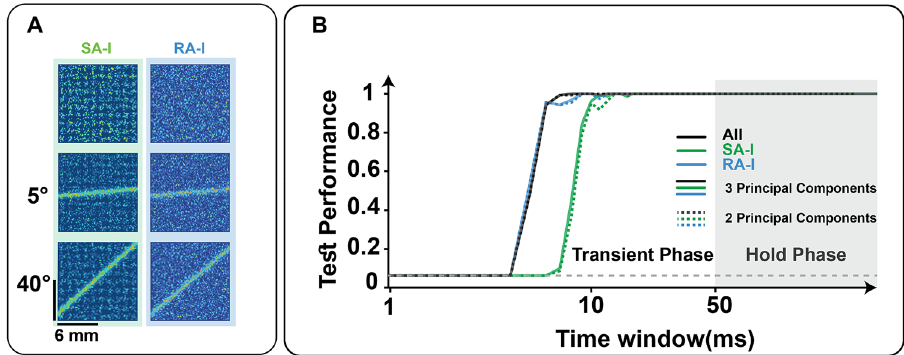
Figure 3. Decoding the orientation of indented edge based on spike count analysis. 16 orientations were tested (5°–80° with 5° steps). ( A ) The indented edges at 5° and 40° activate the mechanoreceptor population. The Left and Right columns indicate the mechanoreceptor grids innervated by SA-I and RA-I afferents, respectively. ( B ) Classification performance for SA-I (green) and RA-I (blue) afferents and the whole population (black) when the edge stimulus indents skin for different durations right after the contact. The PCA algorithm is used for dimensionality reduction and solid curves show the test performance when three principal components are considered. The chance level is shown by the horizontal gray dashed line.